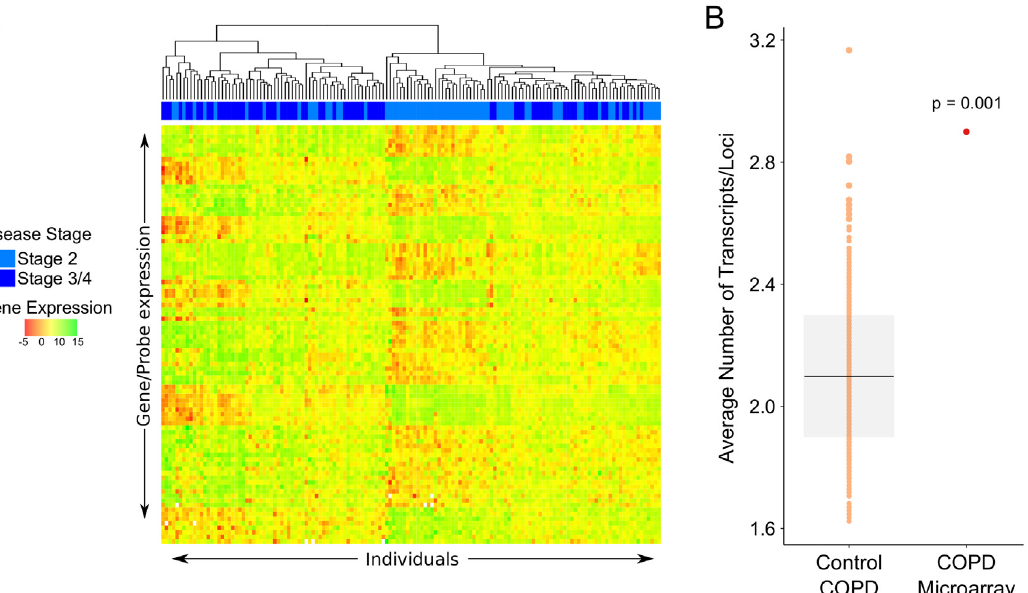
Fig 3. The transcript complexity enrichment of COPD-associated genes is robust. (A) Microarray data from the sputum of ex-smokers diagnosed with COPD stage 2, 3, or 4 identified 85 COPD-associated genes with significant differential expression (gds4265). These 85 genes are shown on the y-axis and individuals are shown on the x-axis with their COPD status marked by disease stage along the top. (B) We calculated the average number of transcripts per loci for these 85 differentially expressed COPD-associated genes along with length-normalized control gene sets. The mean and standard deviation of the control lists are shown (black bar, grey box). These expressed genes are significantly more transcriptionally complex than controls (p = 0.001).